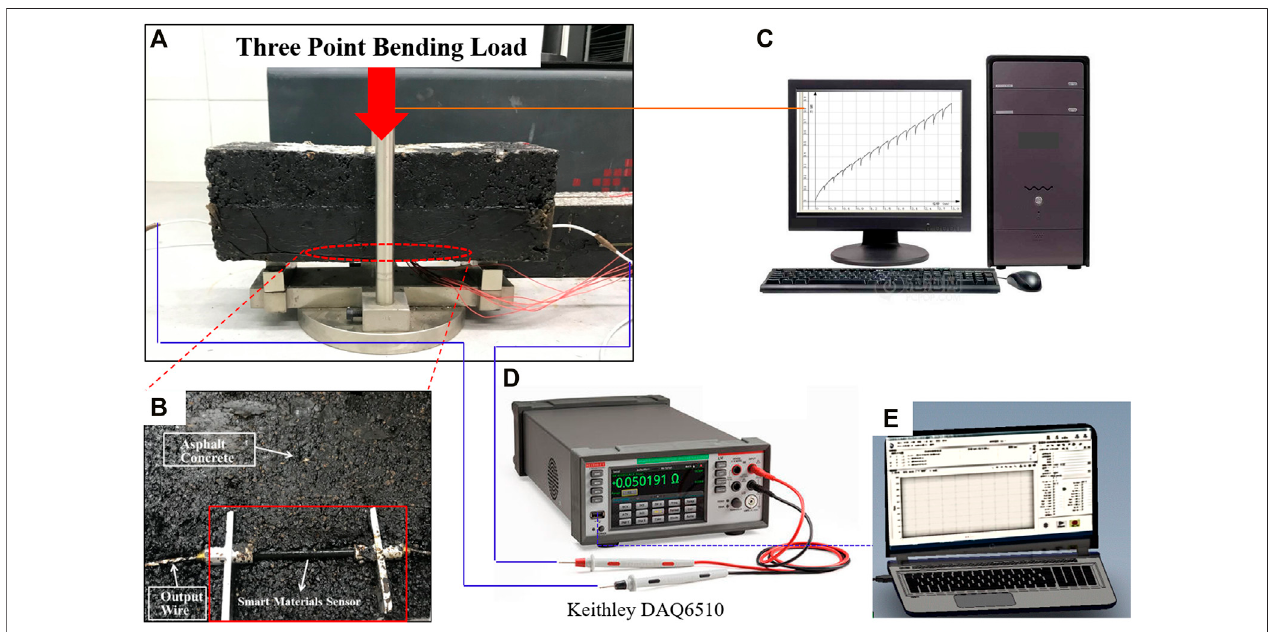
FIGURE 12 | Bending strain test of the self-sensing composites sensor in asphalt concrete